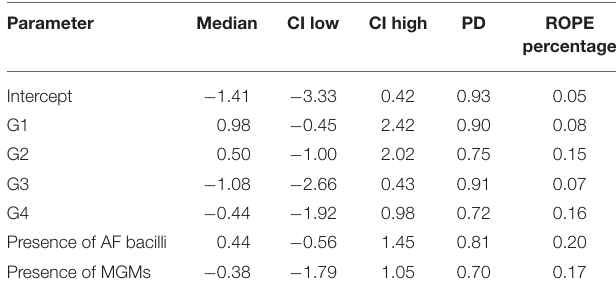
TABLE 1 | Influence of the considered variables on the microbiological status of the lymph nodes (LNs).